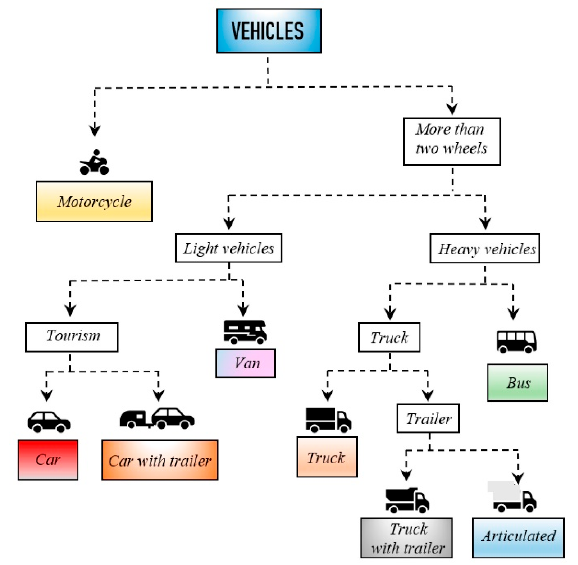
Figure 13. Tree diagram of the discrimination performed.